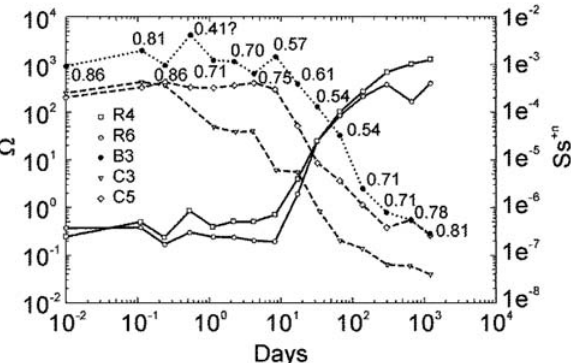
Figure 6. The impedance spectra parameters obtained using circuit #2 as a function of time for cell G24B. Values are given for the full cell area of 25cm 2 . The figures at the B3 curve are the associated n3-values.